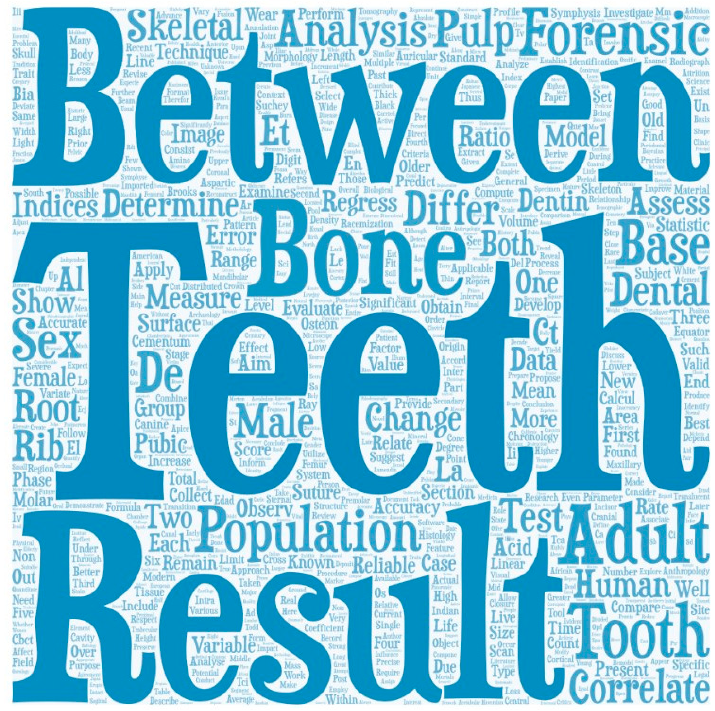
Figure 4. Word cloud for terms used on the title and abstracts for age research.